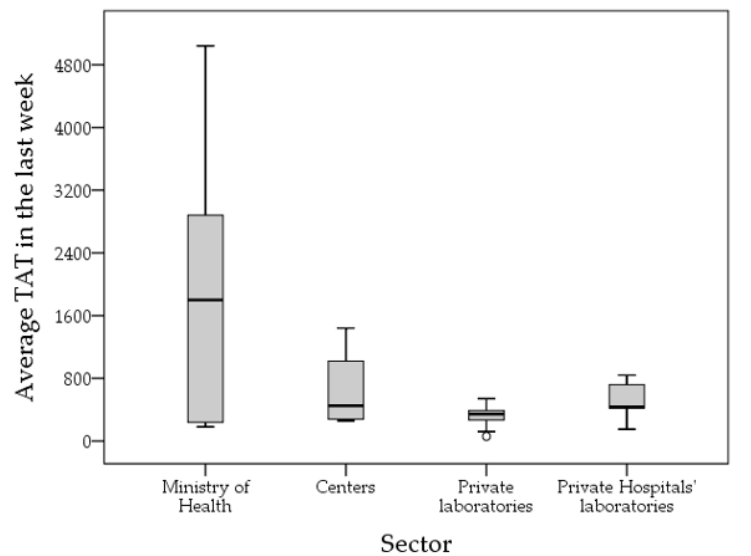
Figure 4. Average turnaround time (TAT) in minutes for the participating laboratories divided by health sector. Centers: university/research/specialized center. Last week: first week of April 2021.